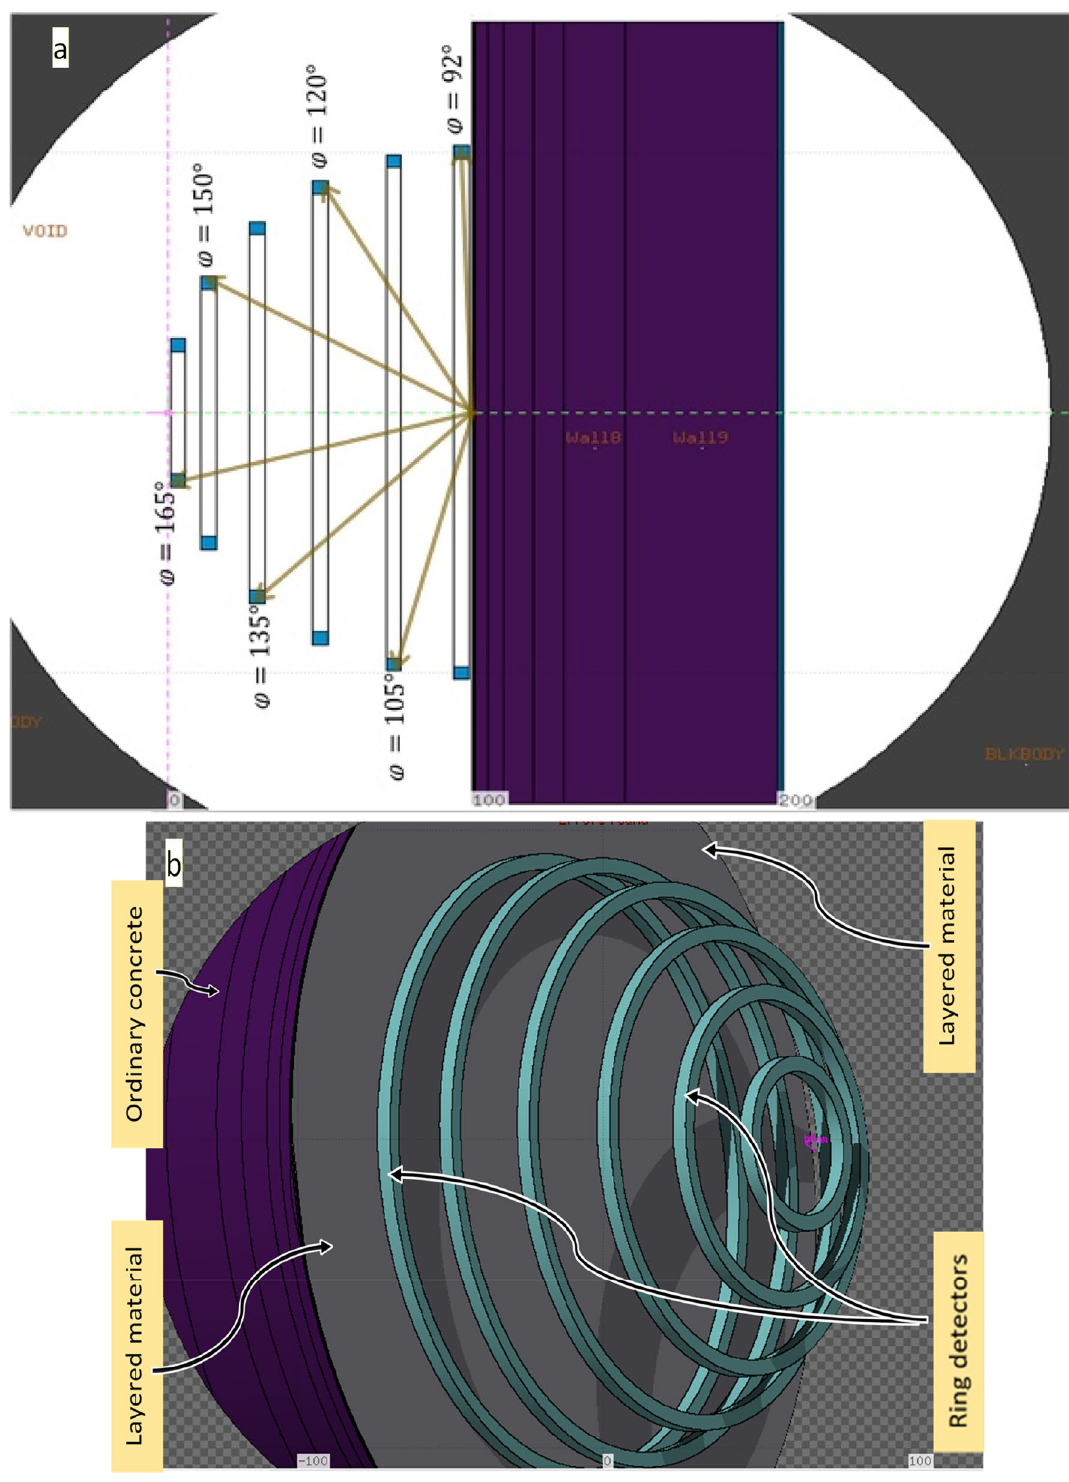
Figure 1. FLUKA Monte Carlo simulation of the ring dosimeters to calculate the dose of backscattered photons at reflection angles with respect to the incident trajectory, normal to the surface ( a : is 2D and b : 3D